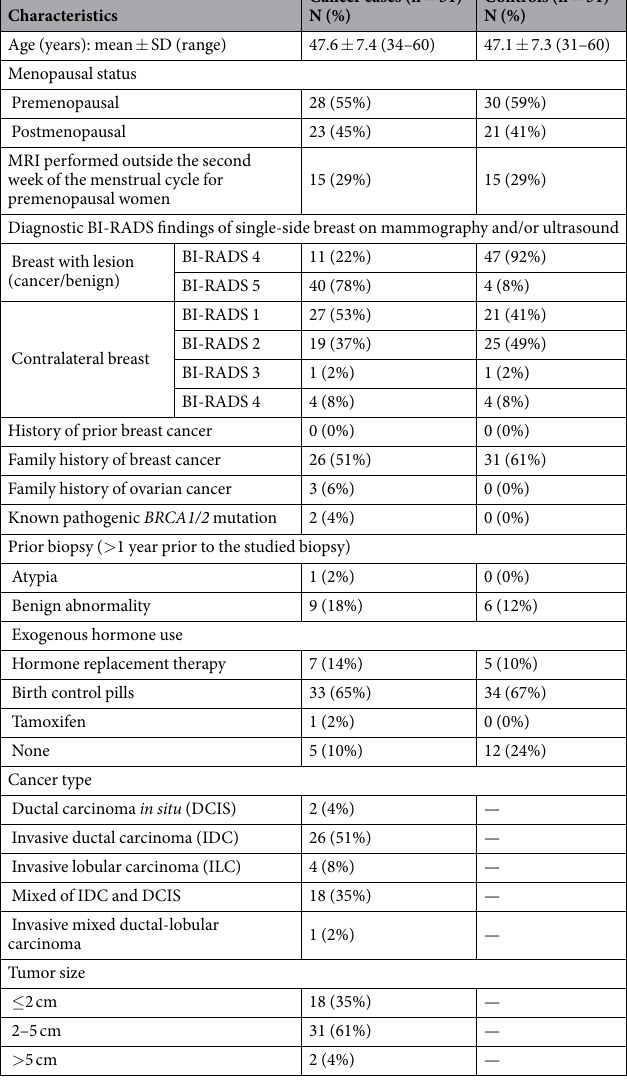
Table 1. Patient characteristics of the 102 patients including 51 breast cancer cases and 51 matched controls. Data are numbers of subjects, with percentages in